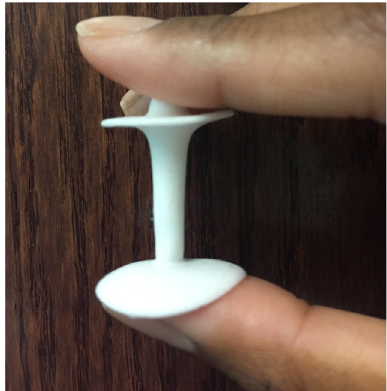
Figure 1. Renew insert device.